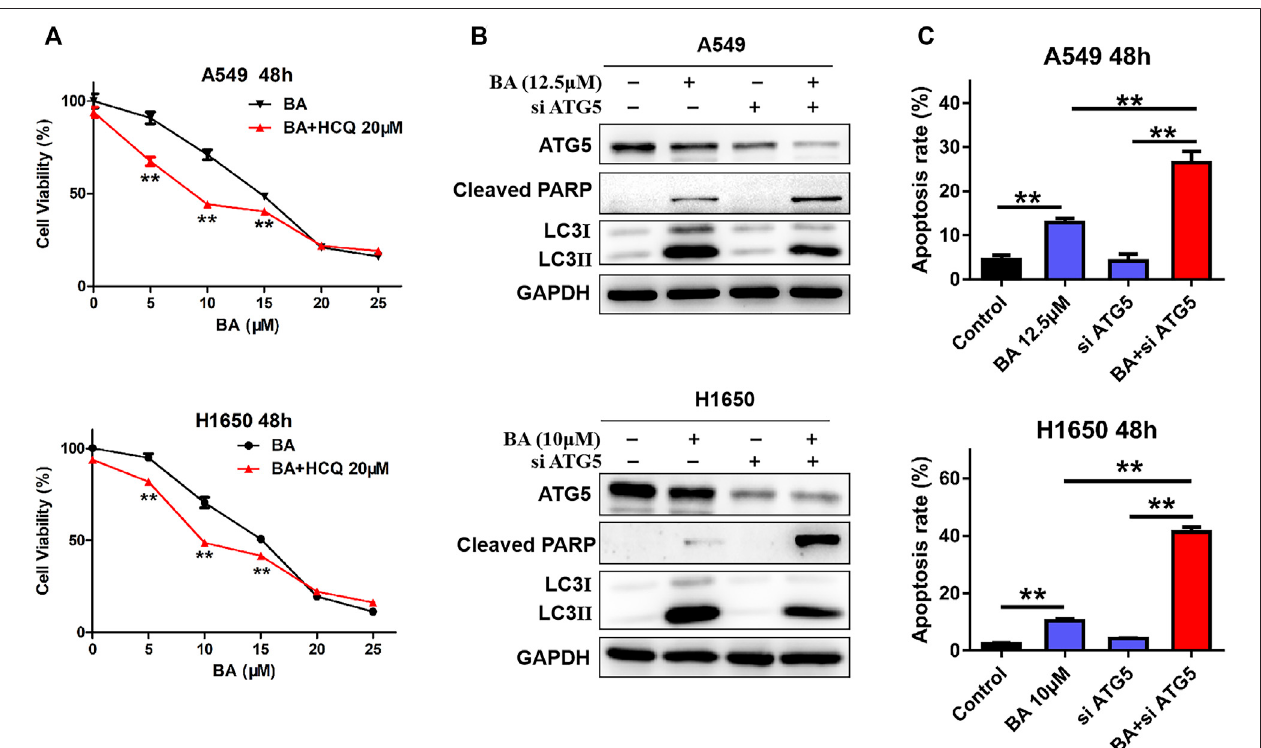
FIGURE 3 | BA-induced autophagy promotes cell survival. (A) A549 and H1650 cells were treated with increasing concentrations of BA alone, or in combination withautophagyinhibitorHCQfor48 h,andcellviabilitywasmeasuredbytheMTTassay. (B) A549andH1650cellsweretransfectedwithsiRNAagainstATG5,followed bytreatment withBA,andtheexpressionsofLC3,ATG5,andcleaved PARPwereanalyzedbyWestern blots. (C) A549andH1650cellsweretransfected withsiRNAof ATG5, following by BA treatment, and apoptosis was assessed using fl ow cytometry. ** p < 0.01.